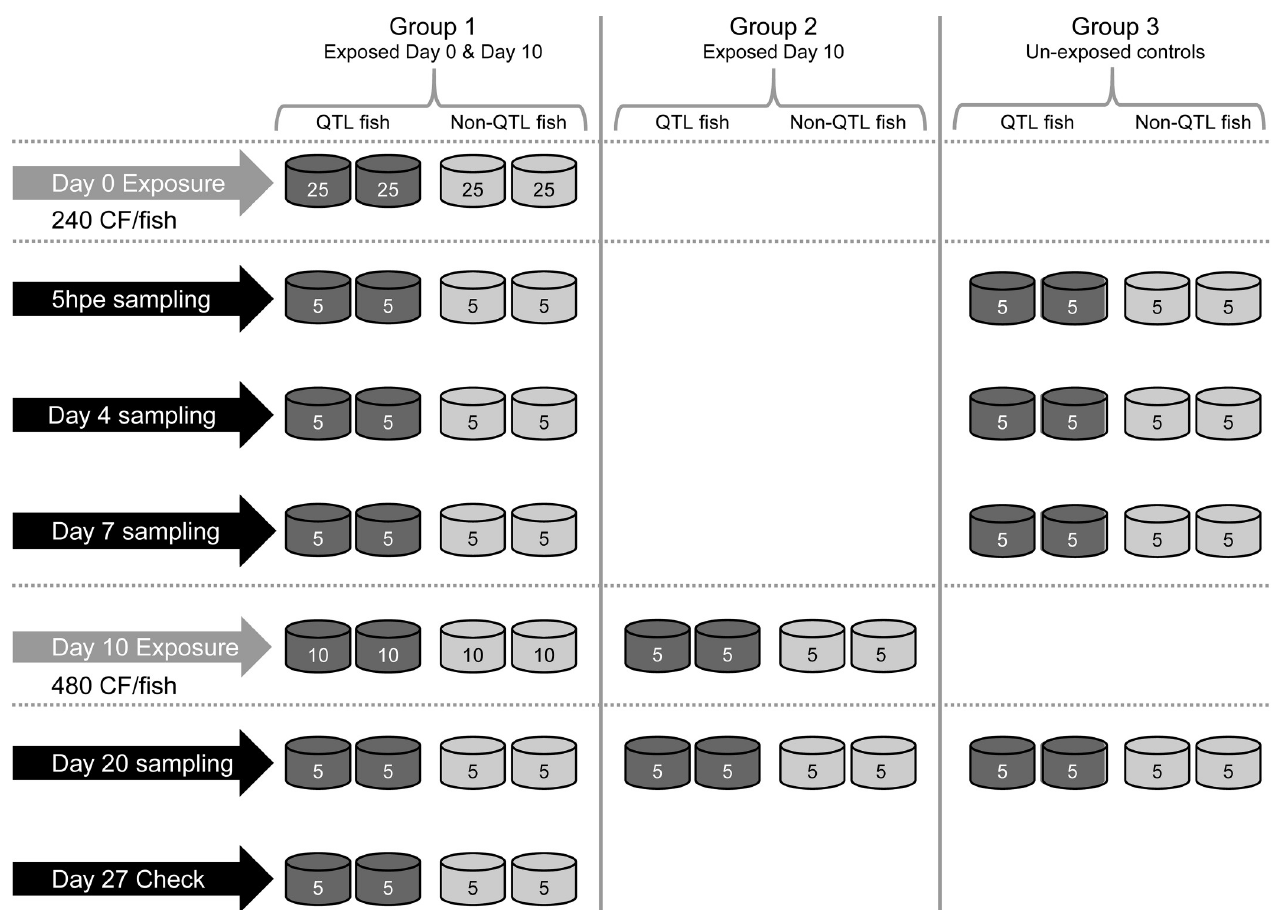
Fig 1. Experimental design of challenge study. At day 0, 4x25 fish were exposed to 240 cercariae per fish (C/F) constituting Group 1. At day 10, the remaining 4x10 of Group 1 and 4x5 na ï ve fish (Group 2) were exposed to 480 C/F. Group 3 was kept un-exposed throughout the entire experiment. At all samplings points, the number of metacercariae in the eyes was enumerated. At all sampling points except Day 27, gill and spleen from all fish were sampled for gene expression analyses and fins for genotyping.